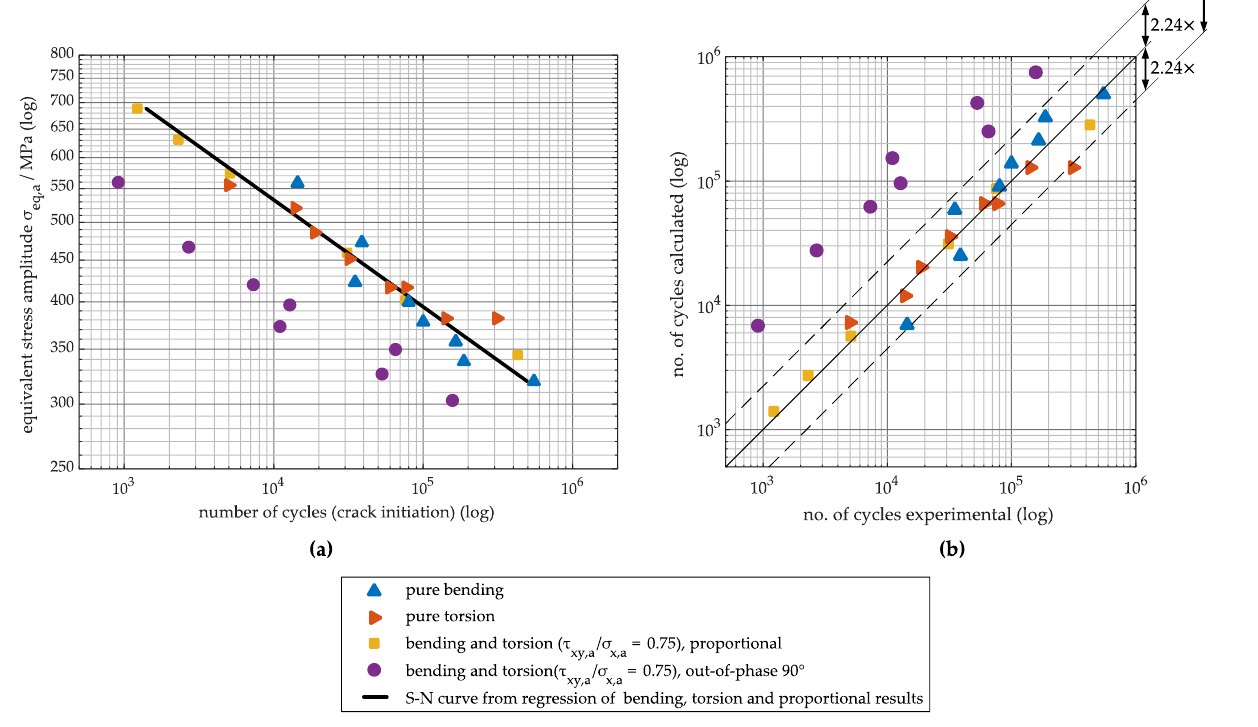
Figure 15. Test results from Figure 12 evaluated with scaled normal stresses as ( a ) equivalent stress amplitudes according to scaled normal stresses and ( b ) number of cycles calculated based on the proportional S – N curve over an experimentally determined number of cycles.